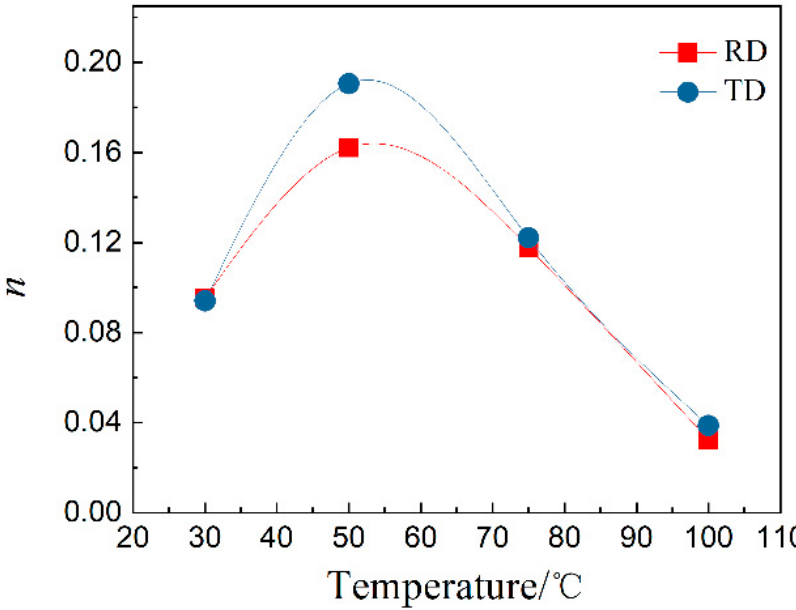
Figure 6. Temperature dependence of work hardening exponent.